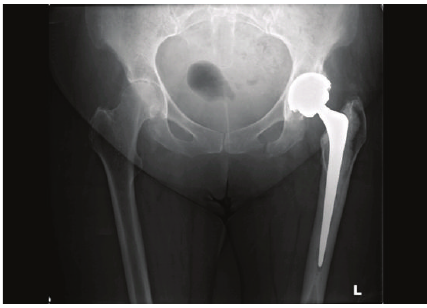
Figure 2: Plain radiograph taken following initial presentation with a fall, showing a fracture of the left inferior pubic ramus.